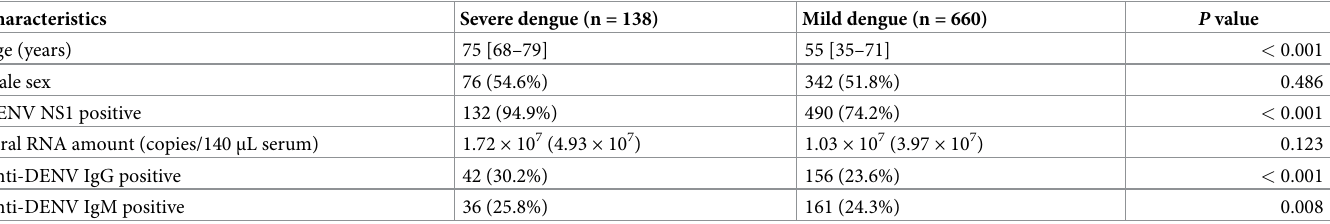
Table 1. Demographic information and laboratory test results of DENV-2-infected patients. Age is reported as the median with interquartile range shown in square brackets. The viral RNA amount is reported as the mean with standard deviation in parentheses. For the remaining variables, the percentages of total number of patients are given in parentheses.